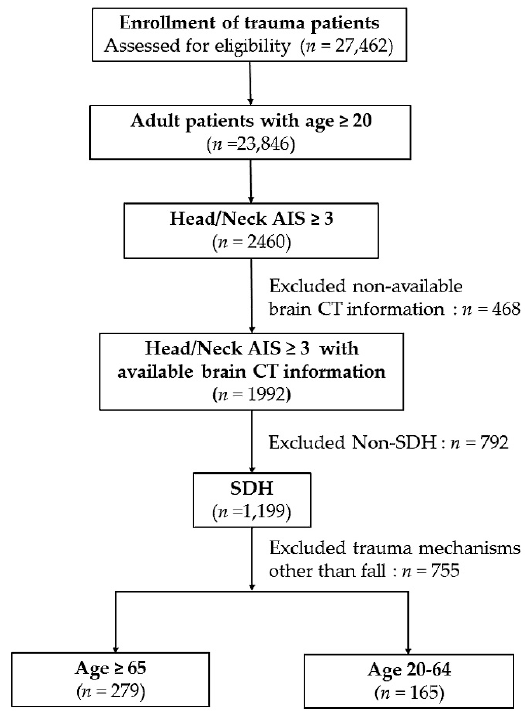
Figure 1. Flow chart showing the method used for selection of adult patients with acute traumatic subdural hematoma (SDH) resulting from a fall and the allocation of patients into two groups: elderly, aged ≥ 65 years, and young adults, aged 20–64 years. Table 1. Characteristics and outcomes of adult patients who sustained a subdural hemorrhage due to a fall.